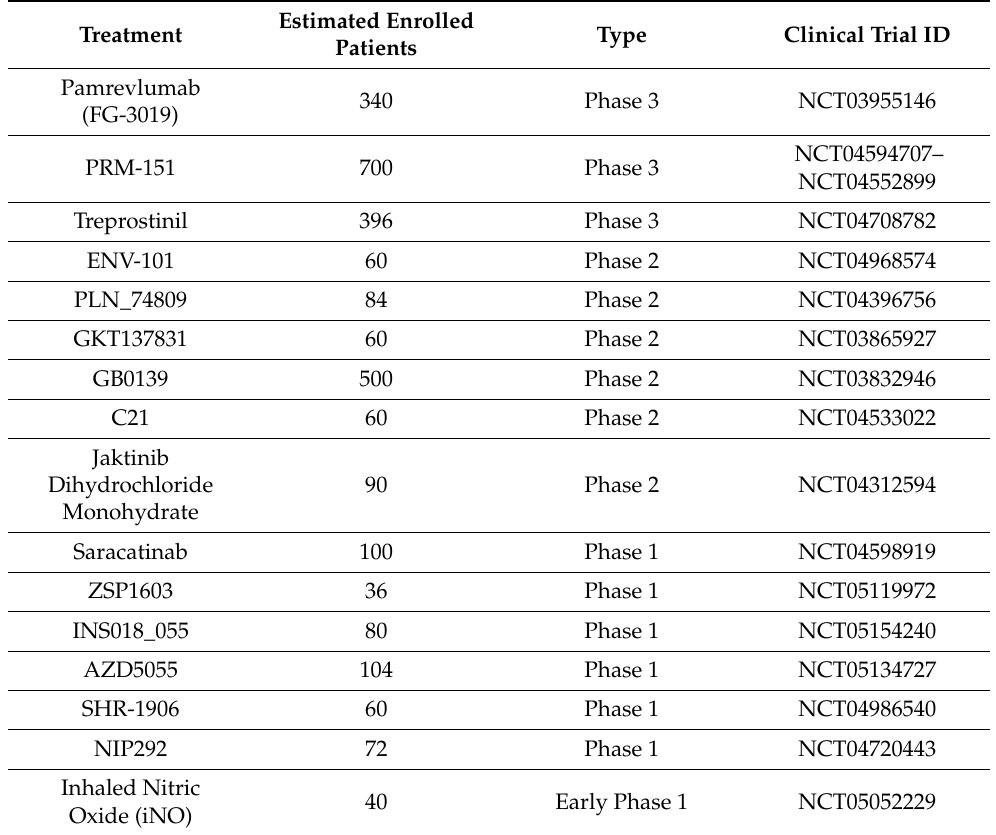
Table 1. Summary of all the interventional clinical trials for IPF that are actively enrolling patients. Estimated Enrolled Type Clinical Trial Treatment Patients